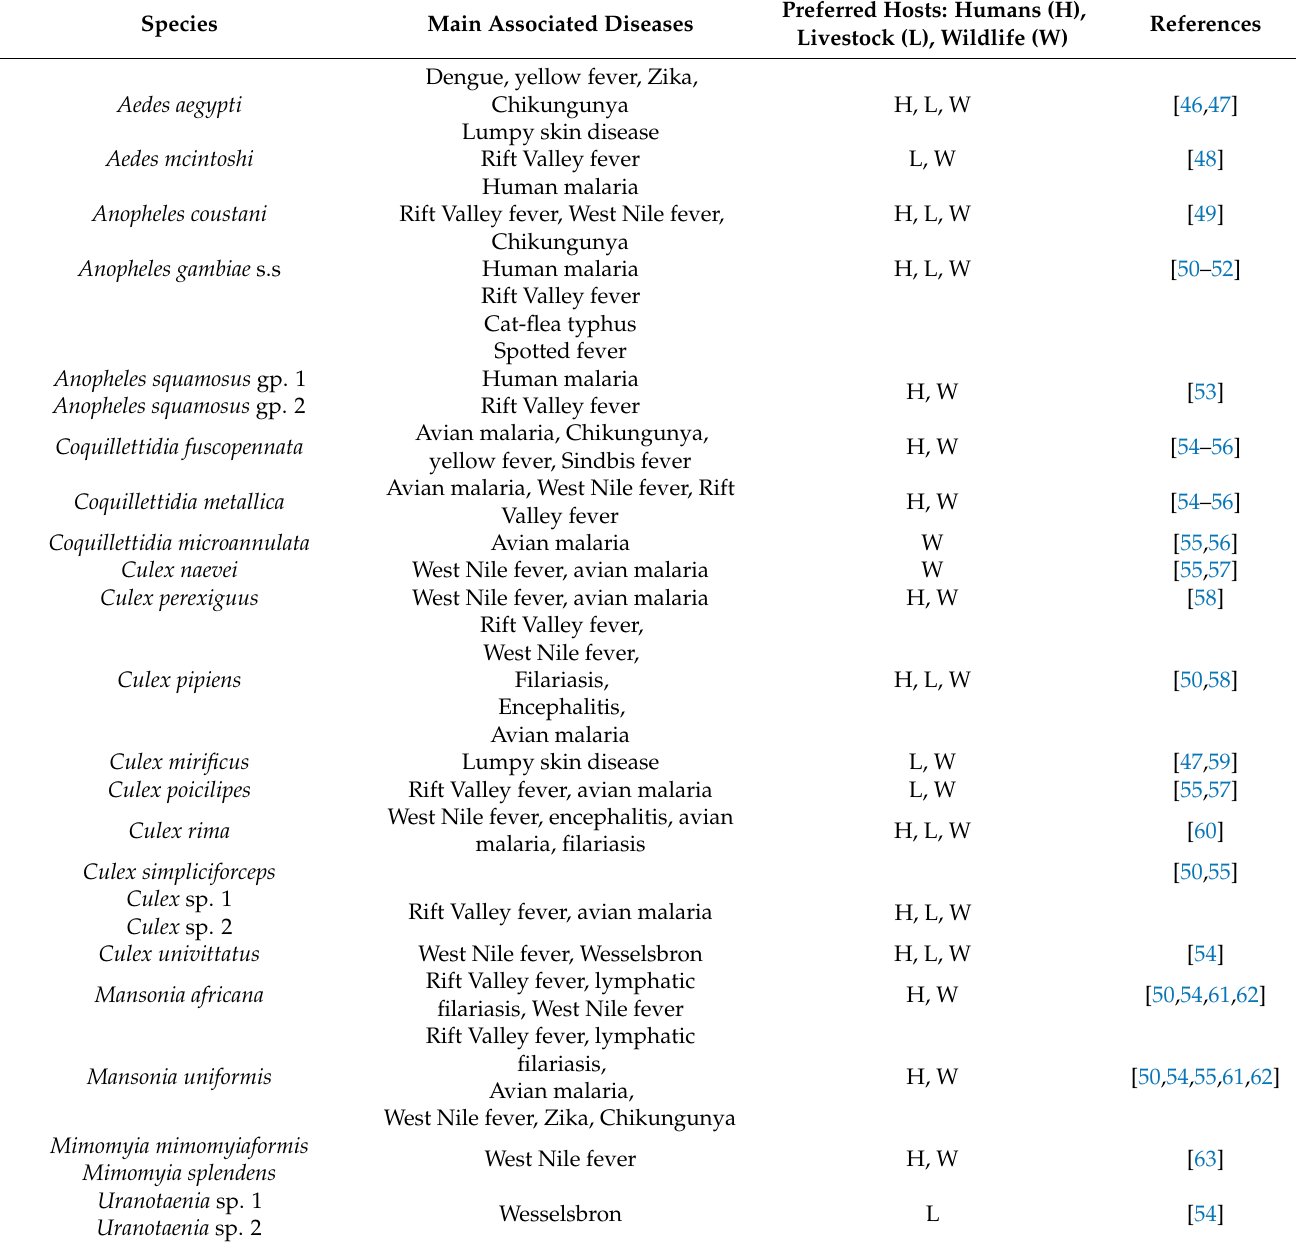
Table 4. Summary of mosquito species identified from touristic areas (Chobe enclave, Okavango and the Central Kalahari Game Reserve) and their main associated diseases in preferred hosts including humans (H), livestock (L) and wildlife